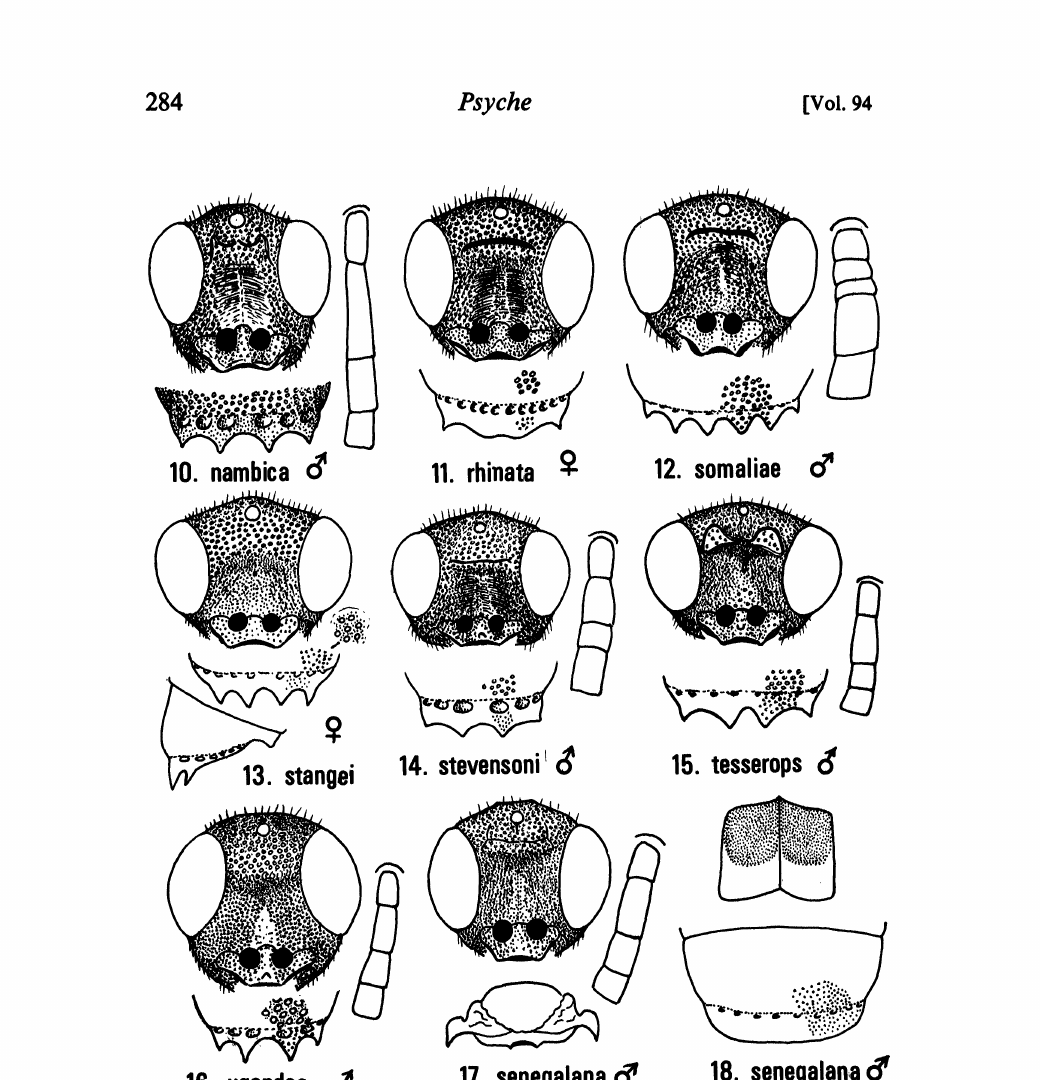
Fig. 11, face and apex of T-III; 10, 12, 14, 15, 16, 17, also pedicel to T-III of antenna (enlarged). Fig. 13, face, T-Ill lateral and apex dorsal. Fig. 18, S-II and T-Ill